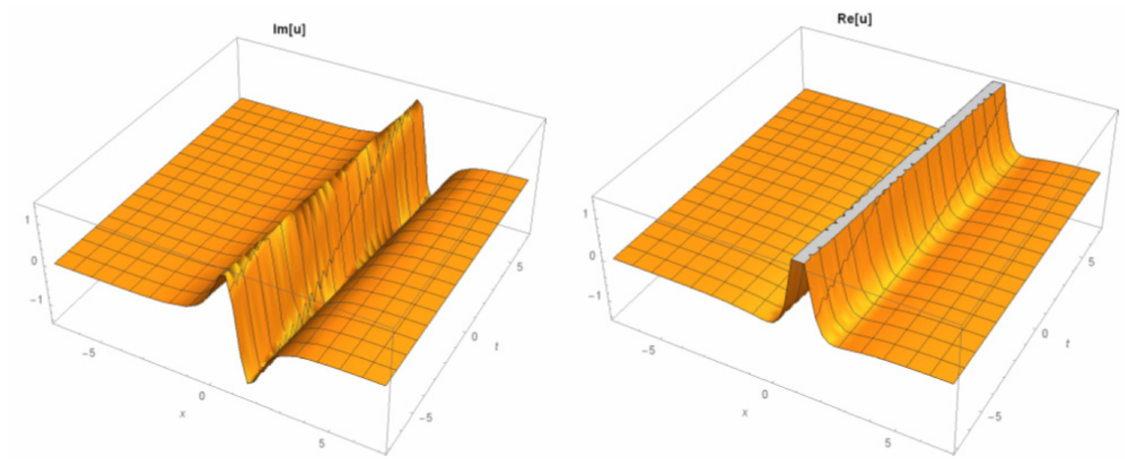
Figure 17. The 3D surfaces of Equation (30) under the values of ε = 5, − 7 < x < 7, − 7 < t < 7.